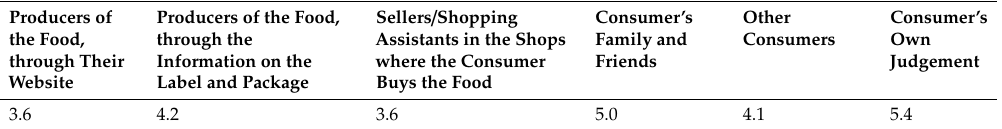
Table 5. Consumers’ average confidence level in the accuracy of information regarding food quality.